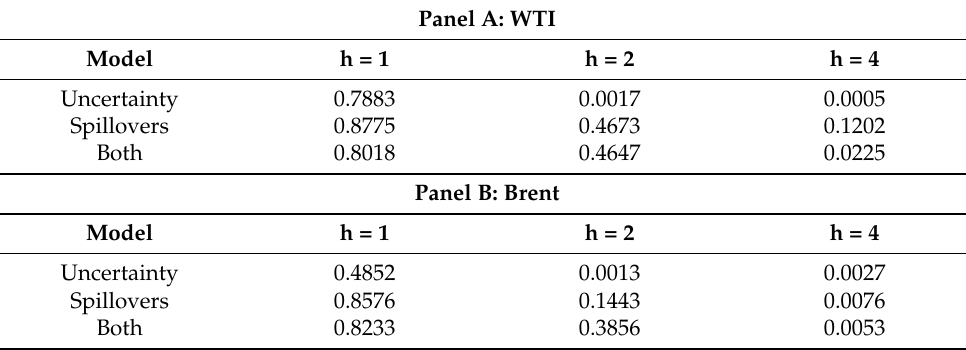
Table 6. Forecasting results for a ridge regression.